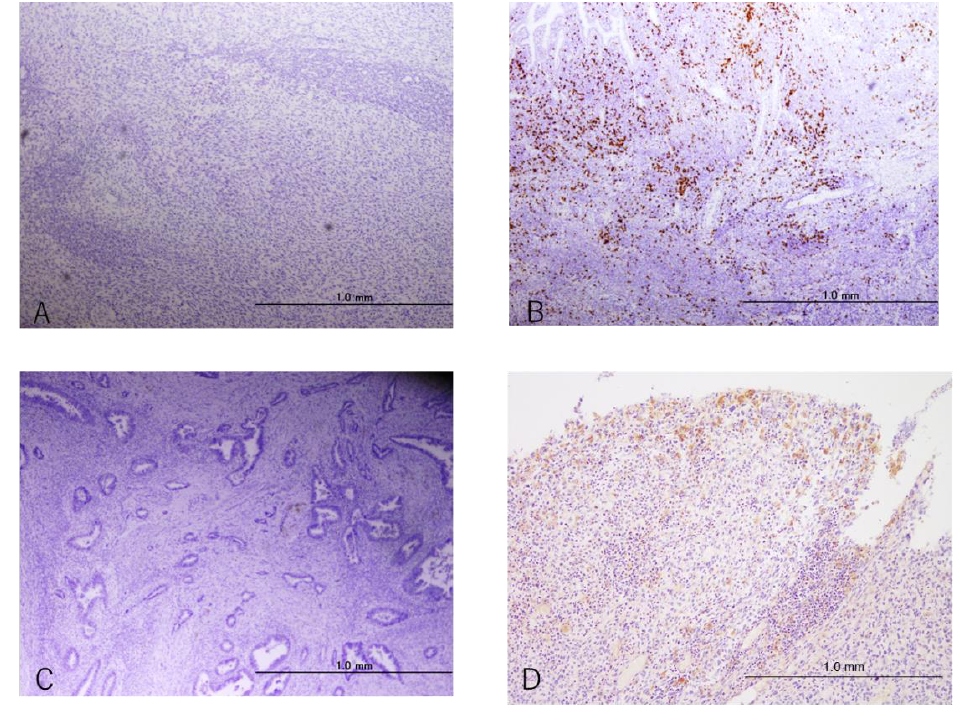
Figure 2. ( A , B ) Representative images of CD8 staining in type II EC. ( A ) Negative expression of CD8 (score 0). ( B ) Positive expression of CD8 (score 3+). ( C , D ) Representative images of PD-L1 staining in type II EC. ( C ) Negative expression of PD-L1. ( D ) Positive expression of PD-L1.